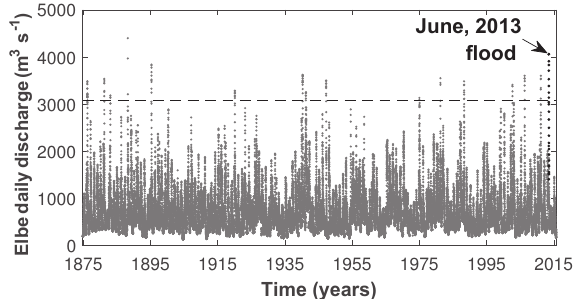
Figure 2. Daily discharge from the Elbe River between 1874 and 2015. The dashed black line indicates the level of 10-year flood, as listed in Table 2. The June 2013 flood is highlighted in black and indicated with an